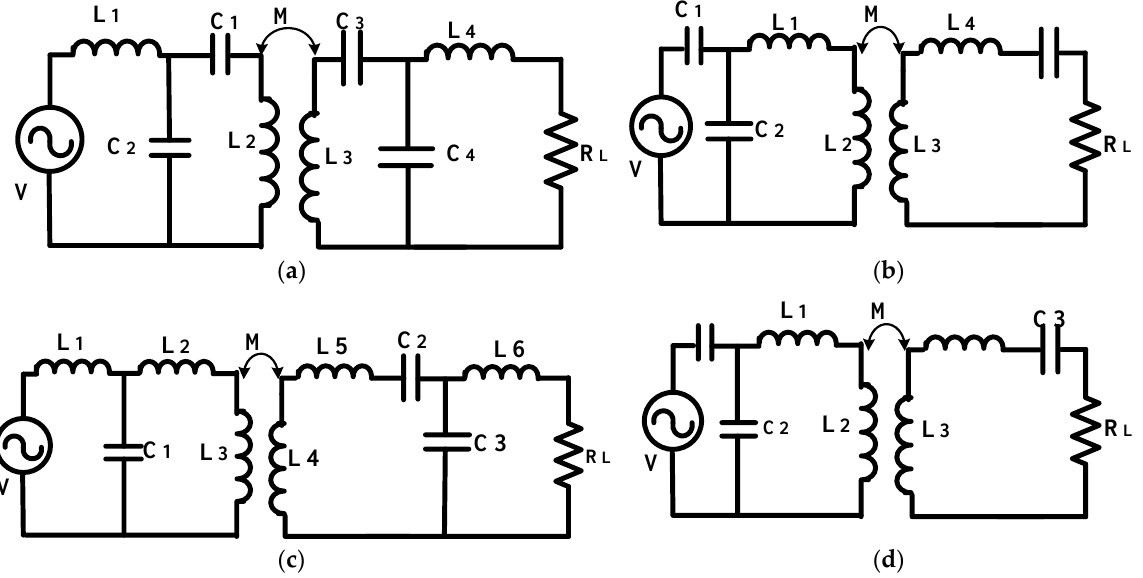
Figure 5. Equivalent circuits of hybrid compensation topologies ( a ) LCC-LCC, ( b ) CCL-LC, ( c ) LCL- LCCL, and ( d ) LC-LC.